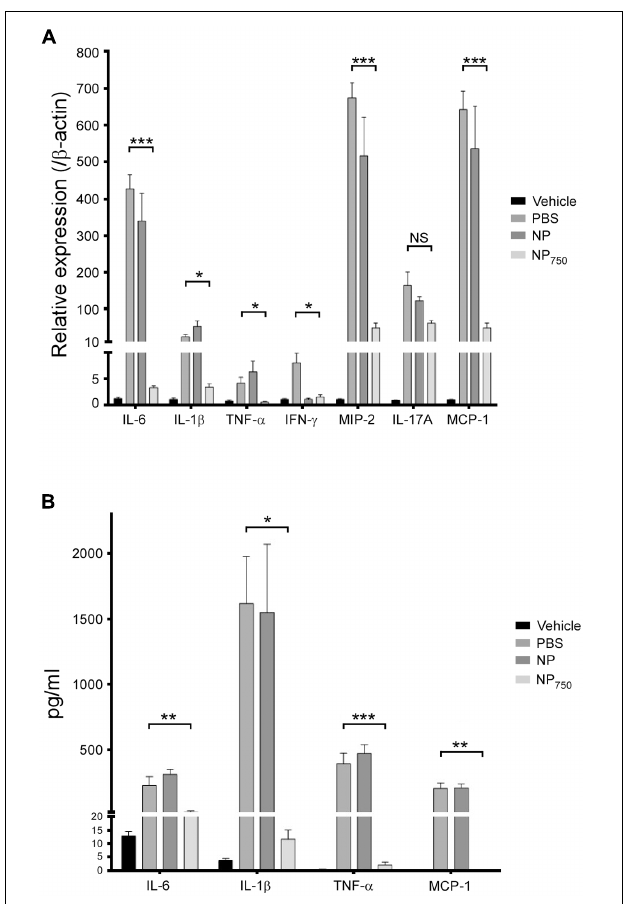
FIGURE 8 | Decreased level of proinflammatory cytokines in C. difficile -infected mice vaccinated by NP-rTcdB. The level of various proinflammatory cytokines and chemokines in colon tissues (A) and GAL (B) of vehicle group, mock-vaccinated group (PBS), empty nanoparticle-vaccinated group, and NP 750 vaccinated group as measured by real-time polymerase chain reactions and ELISA, respectively. All data are presented as mean ± standard deviations and statistical comparisons among groups were analyzed by Student’s t -test ( ∗ p ≤ 0.05, ∗∗ p ≤ 0.01, ∗∗∗ p ≤ 0.001, ∗∗∗∗ p ≤ 0.0001). NS, not significant. All data are representative of at least three independent experiments.